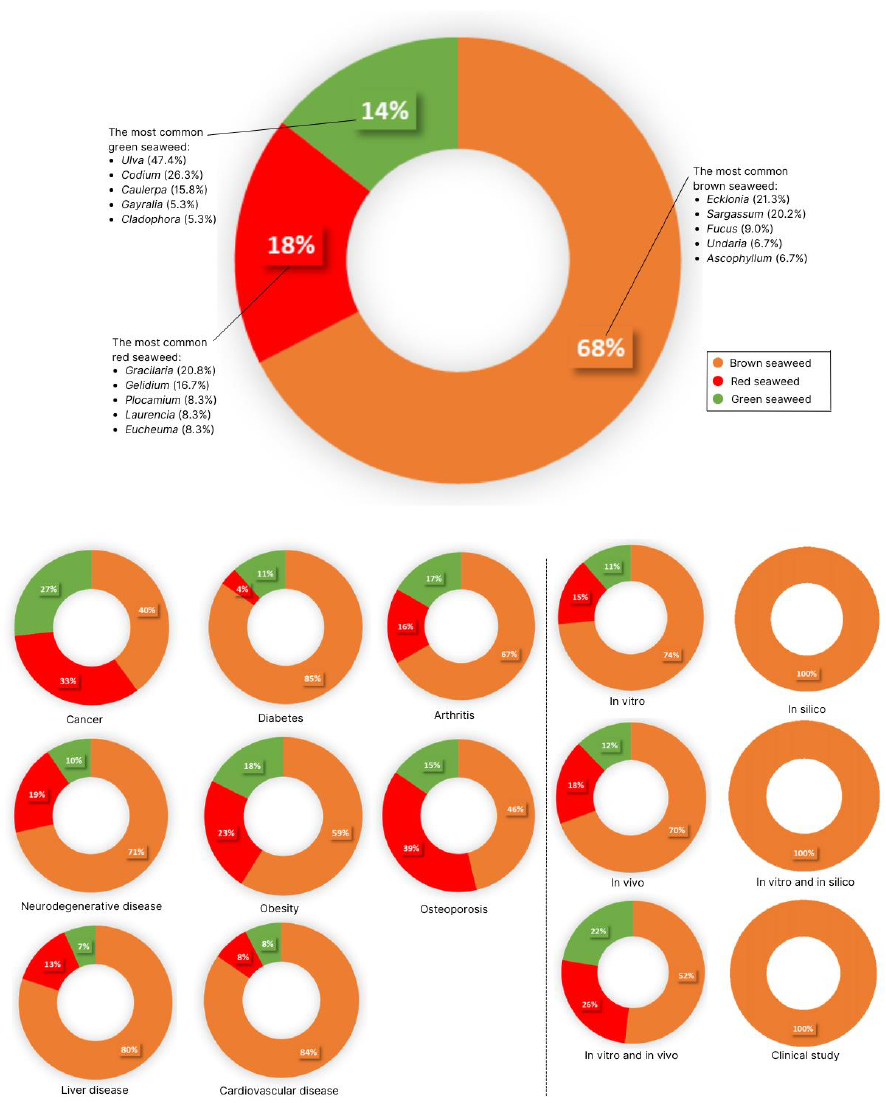
Figure 2. Percentage of published papers of seaweed research on chronic disease based on ( a ) the phyla Chlorophyta (green color), Rhodophyta (red color), and Phaeophyta (brown color); ( b ) chronic disease for each phylum; and ( c ) experimental model for each